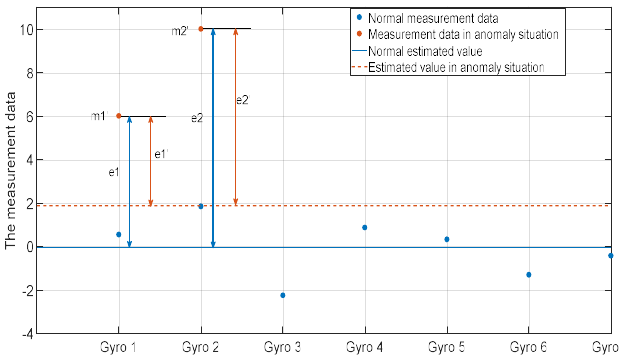
Figure 15. An example of anomalies in the same direction.